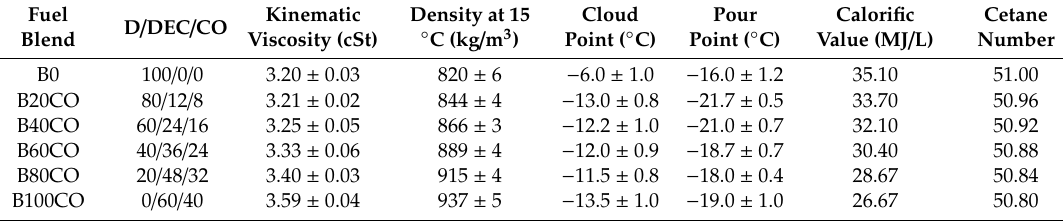
Table 5. Fuel properties of diesel (B0), DEC / CO double blend (B100) and D / DEC / CO triple blends (B20-B80), containing 60% DEC. Experimental data are shown along with the standard deviation obtained from average of three